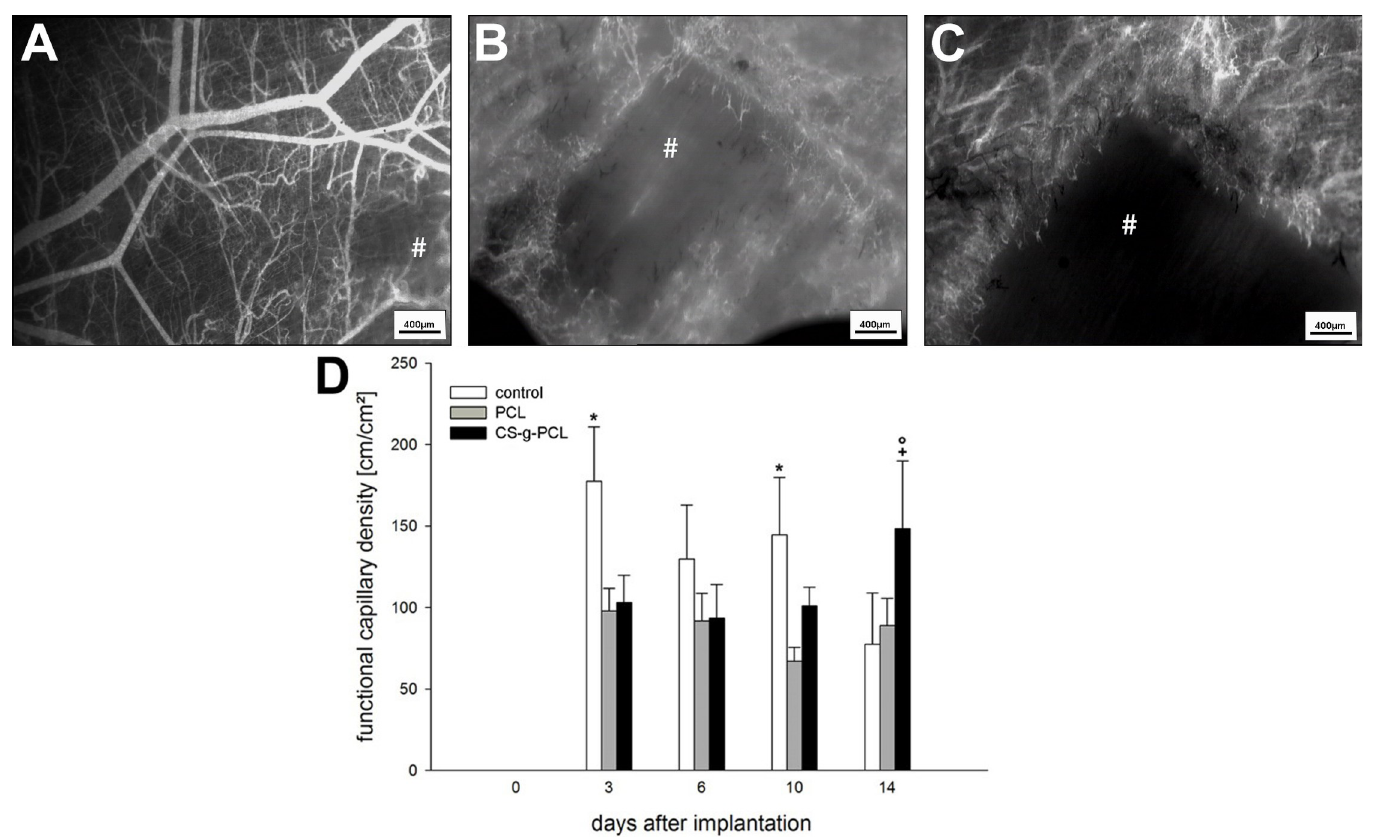
Fig 3. Results of intravital microscopy. (A-C) Intravital microscopic overview images of control (A) , PCL (B) and CS-g-PCL (C) at day 14. (D) Functional capillary density in cm/cm 2 in the border zones of the implants 0, 3, 6, 10 and 14 days after implantation. Means ± SEM; � p < 0.05 vs. PCL and CS-g-PCL; + p < 0.05 vs. PCL on the same day;˚p < 0.05 vs. CS-g-PCL on the preceding time point. Scale bars: 400 μ m.